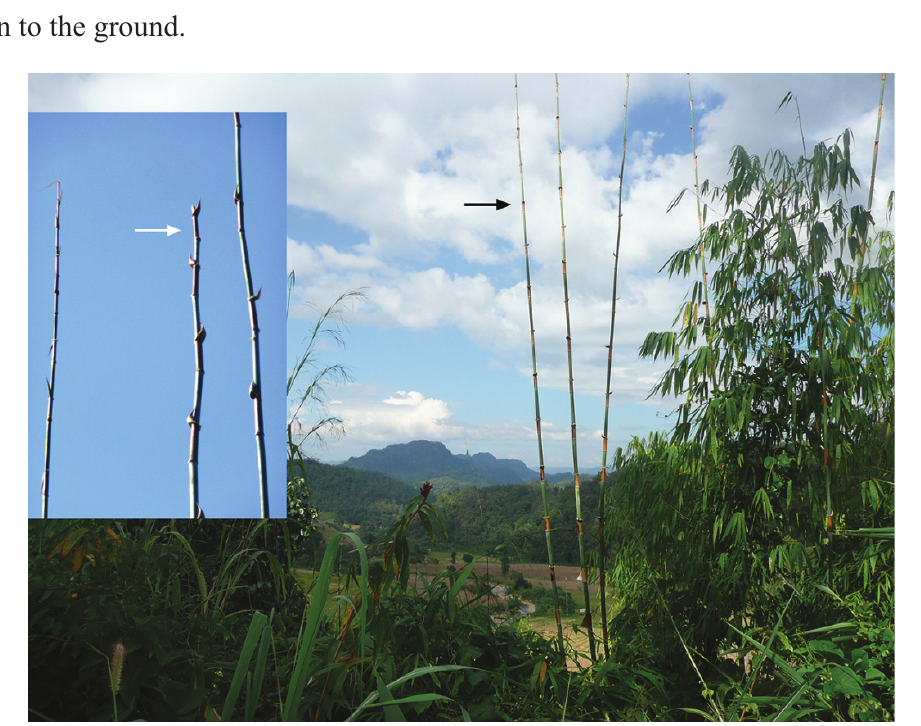
Figure 2. Habitat of A. rufipes in November (N Thailand, Pangmapha district). The black arrow indicates a bamboo shoot of Cephalostachyum pergracile , the host plant of A. rufipes ; Inset: A. rufipes larvae inhabit the fifth to sixth internode below the apex of a bamboo